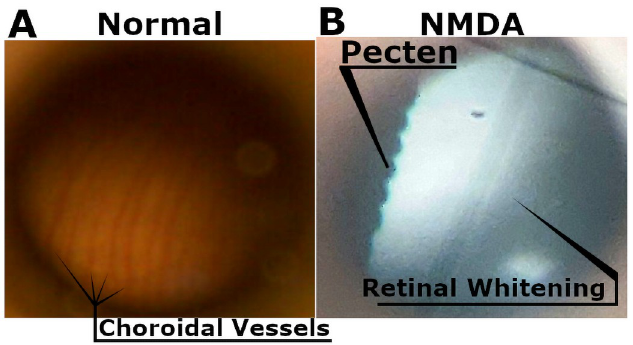
Fig 1. Representative fundus imaging. Choroidal vessels are visible in healthy chick eyes (A). While in NMDA- damaged chick eyes they can no longer be observed, instead we see the retina assume a homogenous white color potentially due to a lack of perfusion (B). The sharp and clear presence of the pecten rules out media opacity in NMDA-damaged eyes.